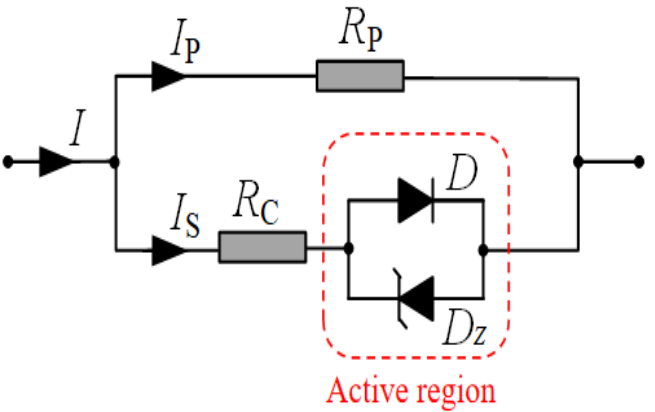
Figure 5. The simplified equivalent circuit of Semiconductor Lasers.